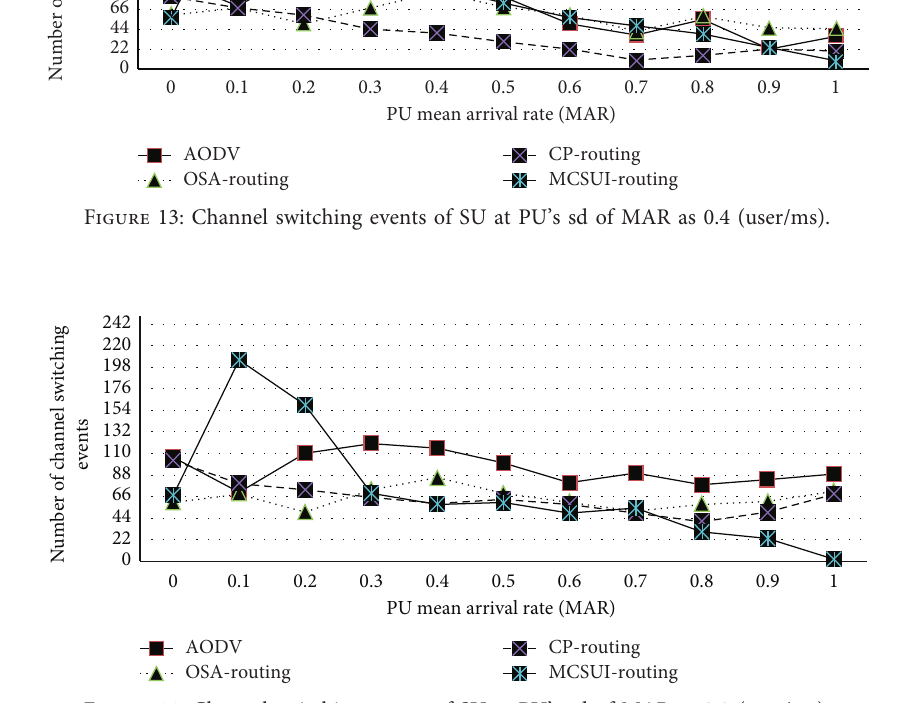
Figure 14: Channel switching events of SU at PU’s sd of MAR as 0.8 (user/ms).